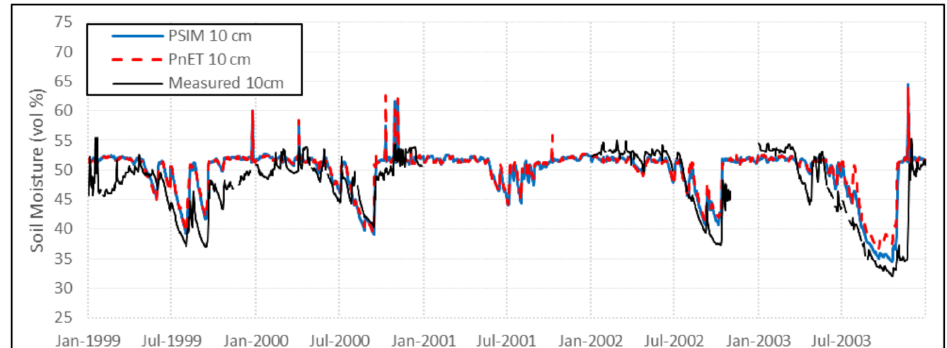
Figure 2. Daily soil moisture measured at the Tower Site, Straits Inclosure during 1999–2003 and simulated by LandscapeDNDC (with PnET and PSIM as the vegetation modules). Measured data are from a fixed probe at the Tower